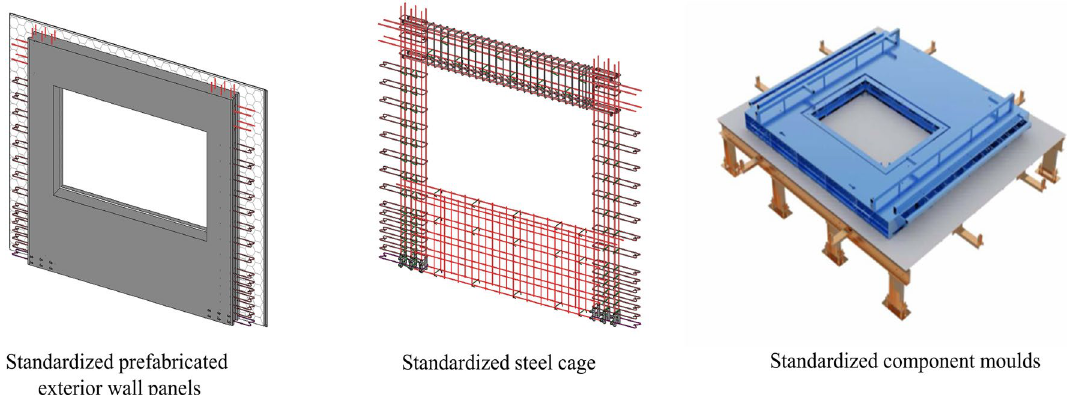
Figure 2. Integrated standardised design technology of PC components, steel cages and moulds.